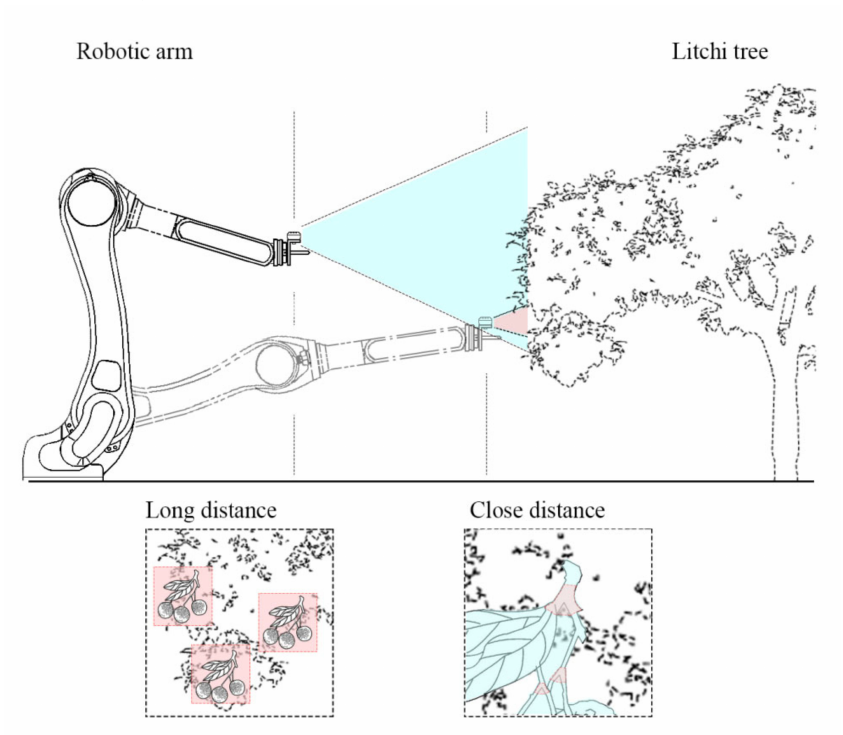
Figure 4. Two-stage hand–eye coordination control